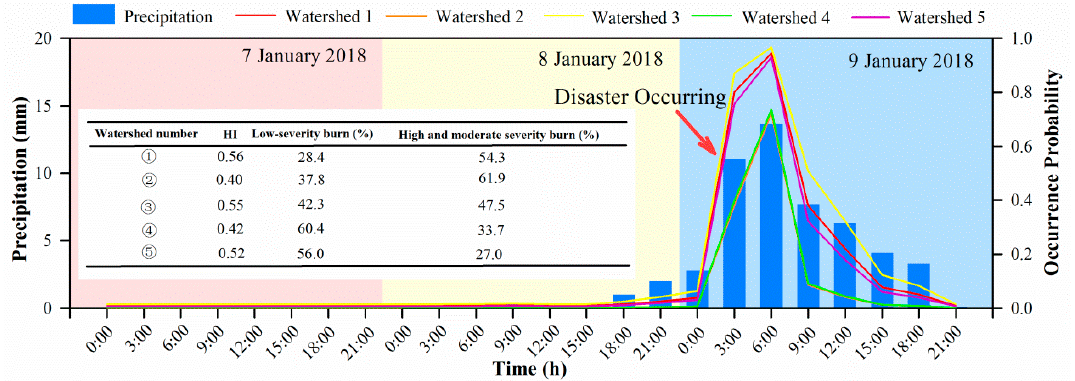
Figure 12. Change of post-fire debris flow occurrence probability of each watershed around Montecito along with rainfalls at different times.